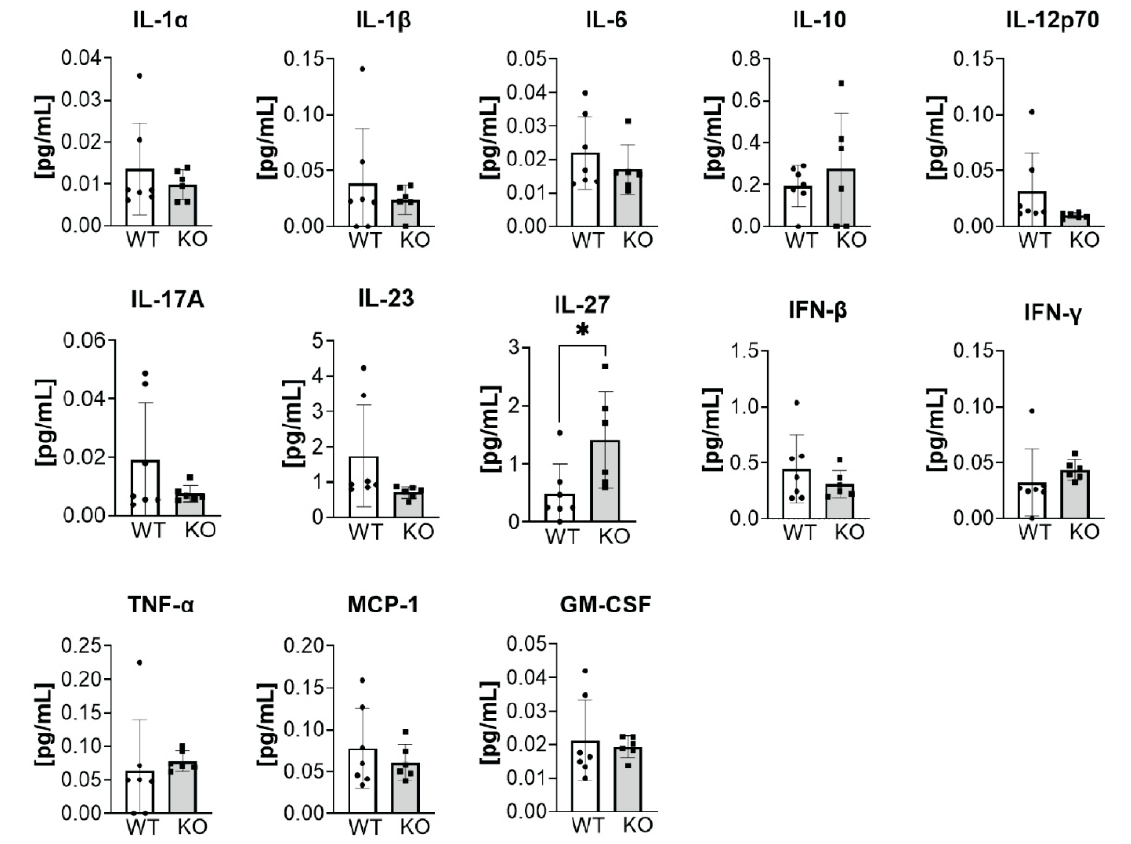
Figure 5. Plasma cytokine measurements in naïve Sftpc-WT and Sftpc-KO mice treated with TAM. Flow cytometry was performed to compare the basal concentration levels of 13 cytokines in the plasma of 7 Sftpc-WT (white bars) and 6 Sftpc-KO (gray bars) mice. Note that only IL-27 was different between the groups with a 3-fold higher concentration in the plasma of Sftpc-KO mice (unpaired t -test, * p = 0.032).